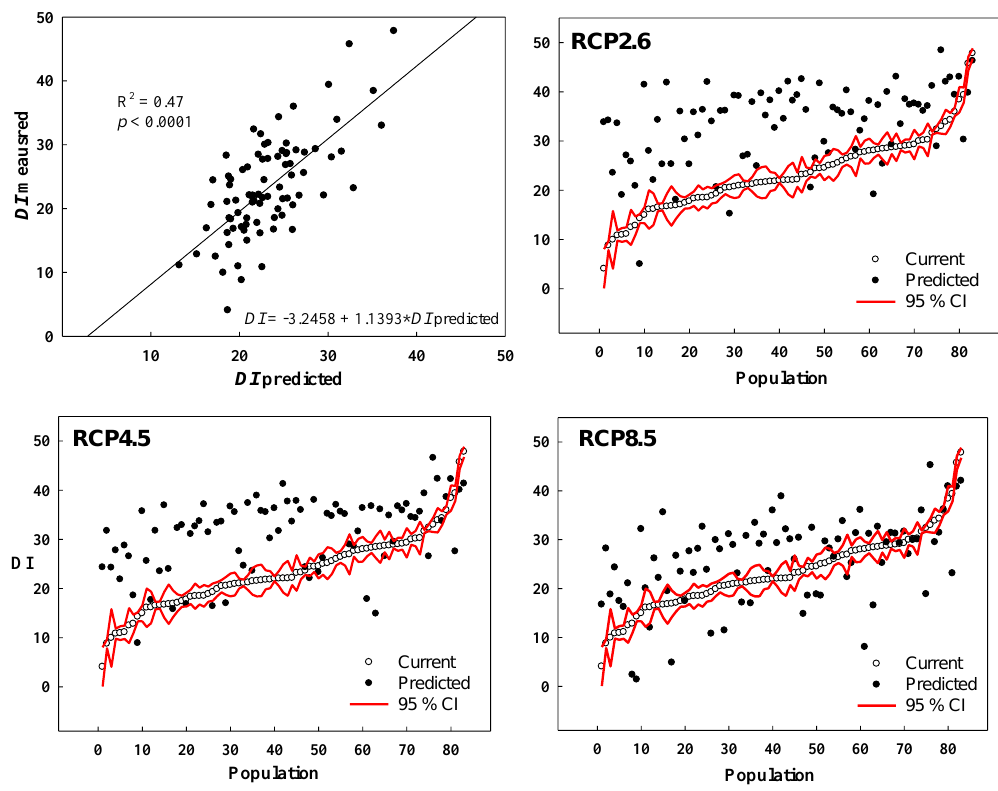
Figure 2. Seed dormancy (DI) prediction in 2050s. (a) Linear relationship between predicted DI and DI used for the correction of pre- dicted seed dormancy; (b) corrected seed dormancy prediction using representative concentration pathways (RCP) 2.6, 4.5 and 8.5, respec- tively. Note: (1) model for seed dormancy prediction, DI = (2.4819 + ecosystem zone ) + 2.7079 × Eref07 – 0.9284 × Eref_summer + 6.6170 × DD_0_summer [refer to Table S2 for intercept adjustment in each ecosystem zone]; (2) the population was ranked as per its current DI in ascending order and 95% confidence interval (CI) was